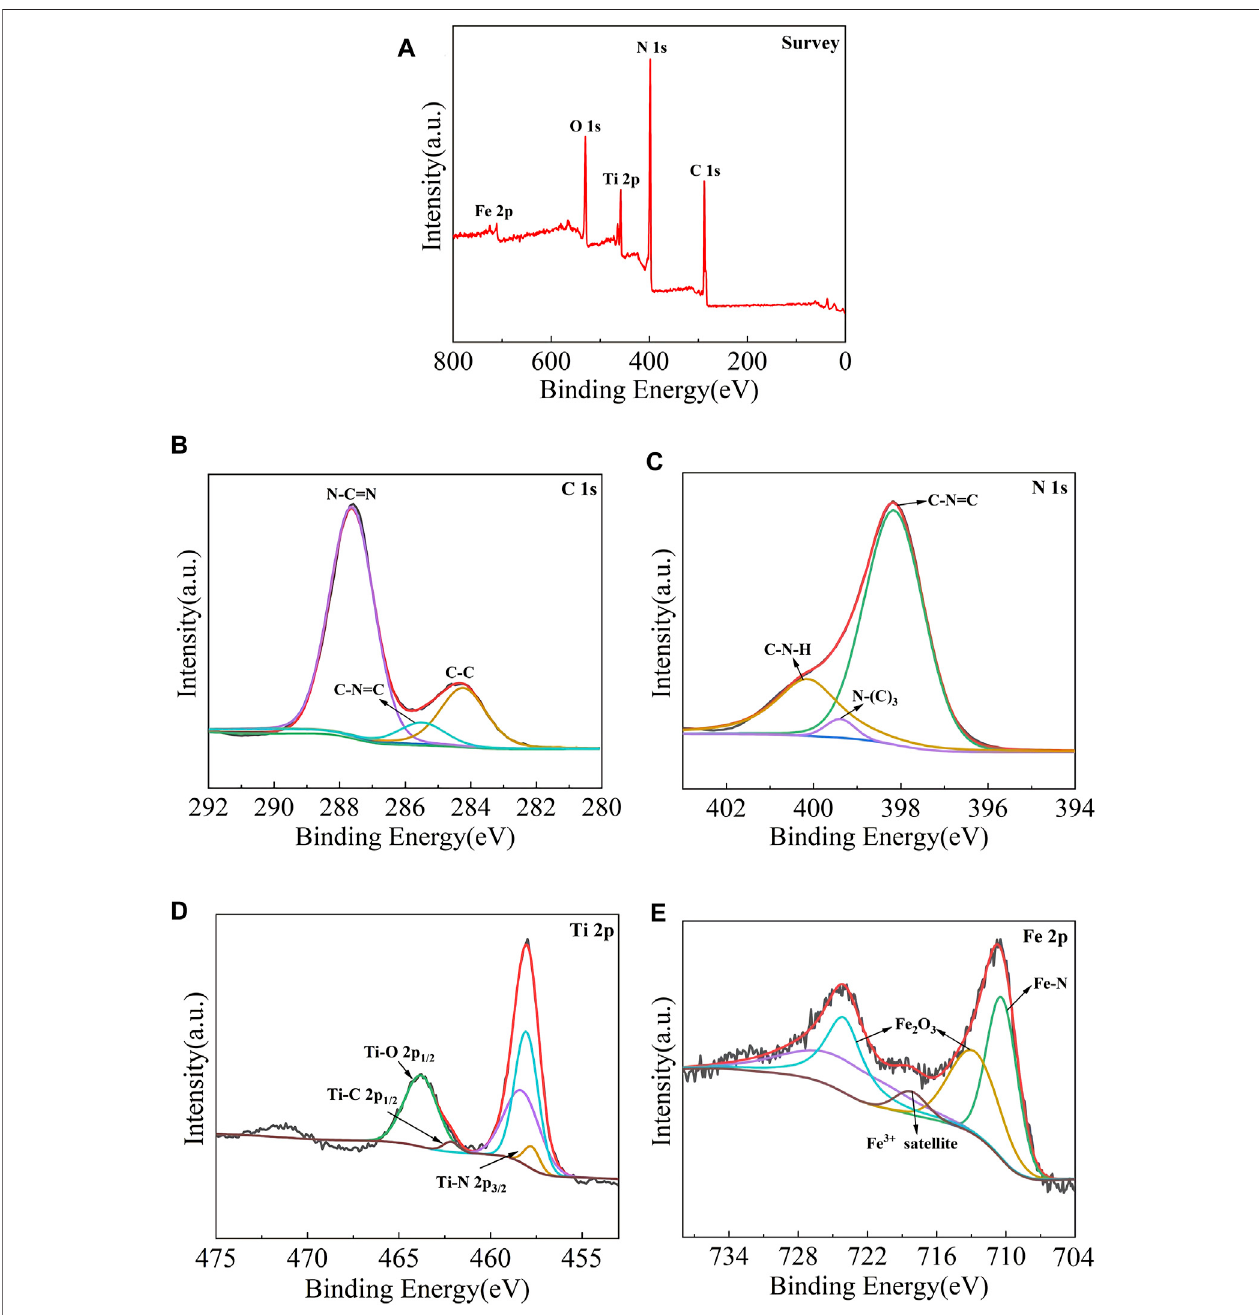
FIGURE 4 | XPS pattern of (A) Fe-C 3 N 4 /Ti 3 C 2 composites, High-resolution XPS spectra comparison of (B,C) 1s and (C) N 1s and (D) Ti 2pand (E) Fe